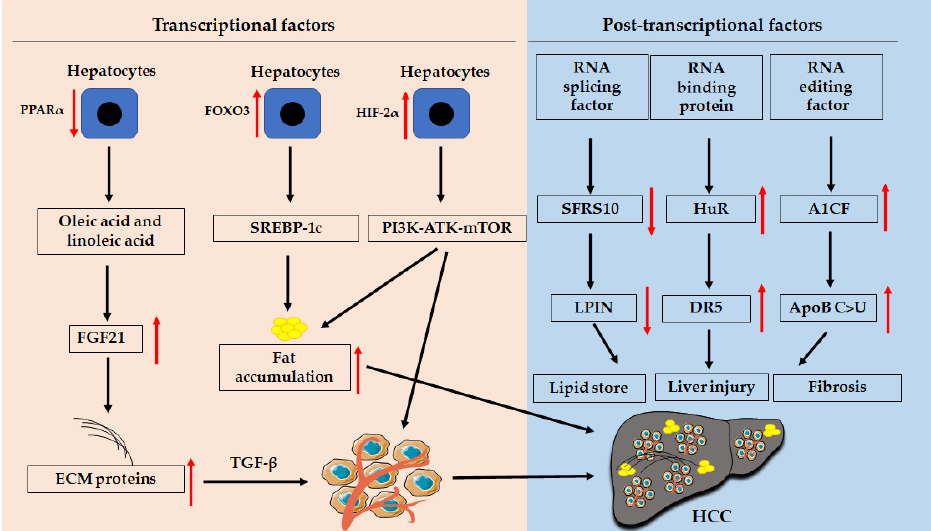
Figure 2. T ranscriptional and post-transcriptional factors mediated the progression of NAFLD and HCC. Abbreviations: AKT: protein kinase B; ApoB: apolipoprotein B; A1CF: catalytic polypeptide